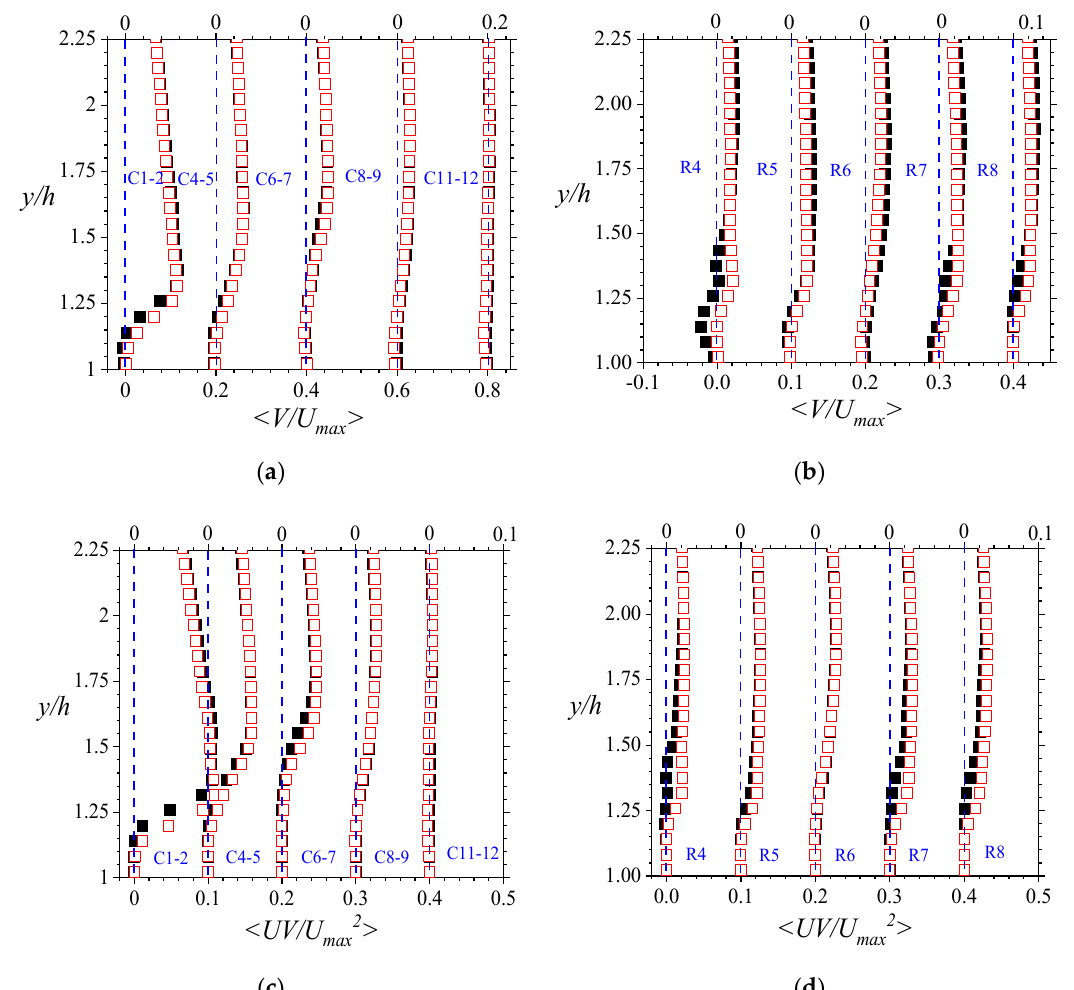
Figure 13. Turbulence quantities < V/U max >, and < UV/U max2 > are respectively line-averaged mean wall-normal velocity, and momentum flux, normalized by the local maximum line-averaged streamwise mean velocity in open and porous regions. Here, the profiles for the flow in the open region are shown. Staggered plots ( a , c ) show the streamwise variations whereas ( b , d ) demonstrate the spanwise variations. The denominations C and R respectively stand for columns and rows, and are illustrated in Figure 1. Black-filled boxes are the results for Test A , and red-open boxes are for results for Test B .